Question: What visual encoding does this figure use to show its data?
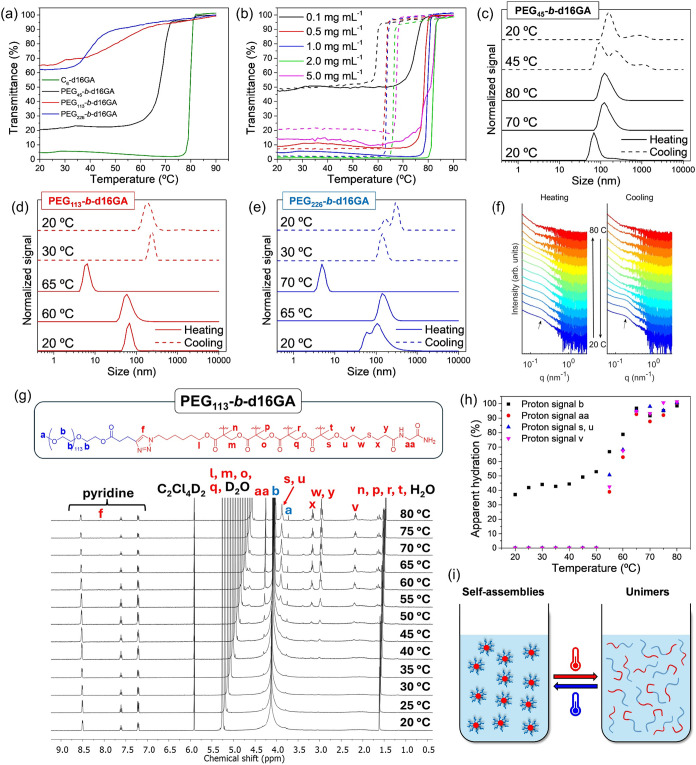
Answer: line